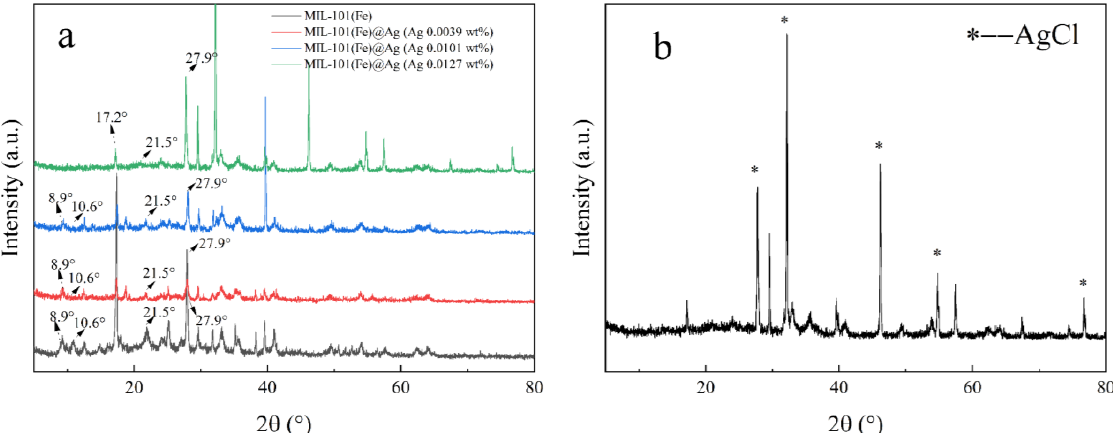
Figure 2. ( a ) Comparison of the PXRD spectra of MIL-101(Fe), MIL-101(Fe)@Ag (Ag 0.0039 wt%), MIL-101(Fe)@Ag (Ag 0.0101 wt%), and MIL-101(Fe)@Ag (Ag 0.0127 wt%). ( b ) PXRD spectrum of MIL-101(Fe)@Ag (Ag 0.0127 wt%).